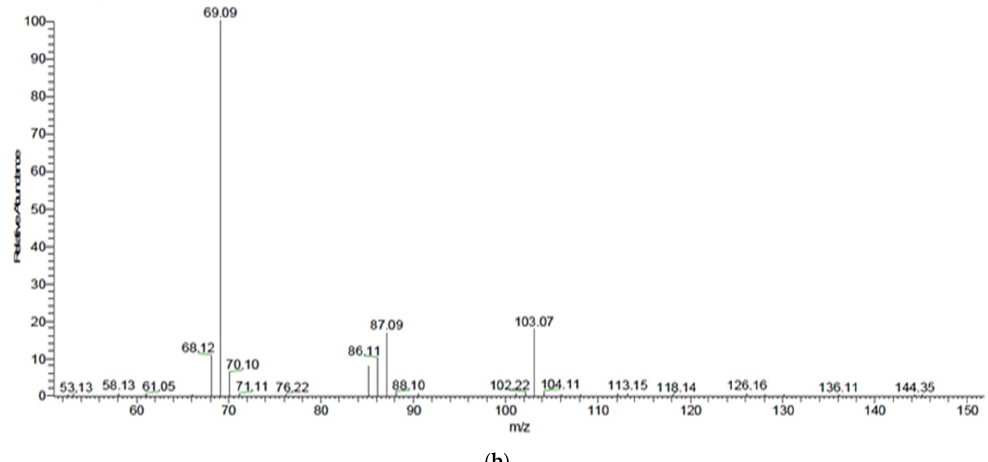
Figure 3. ( a ) Total GC-MS chromatogram of PHB extracted from Bacillus paramycoides. ( b ): The mass spectrum of isopropyl ester of 2-butenoic acid of PHB extracted from Bacillus paramycoides.